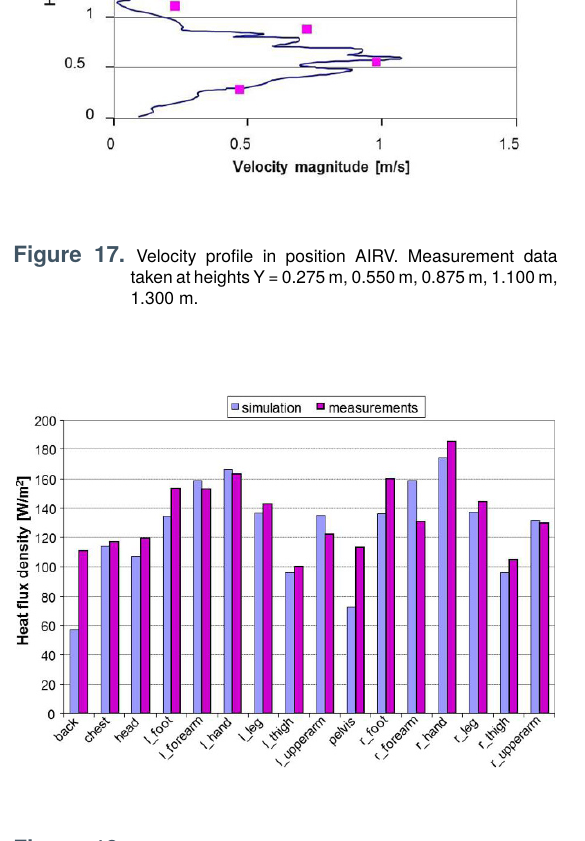
Figure 18. Simulated and measured heat flux density from the segments of the mannequin.